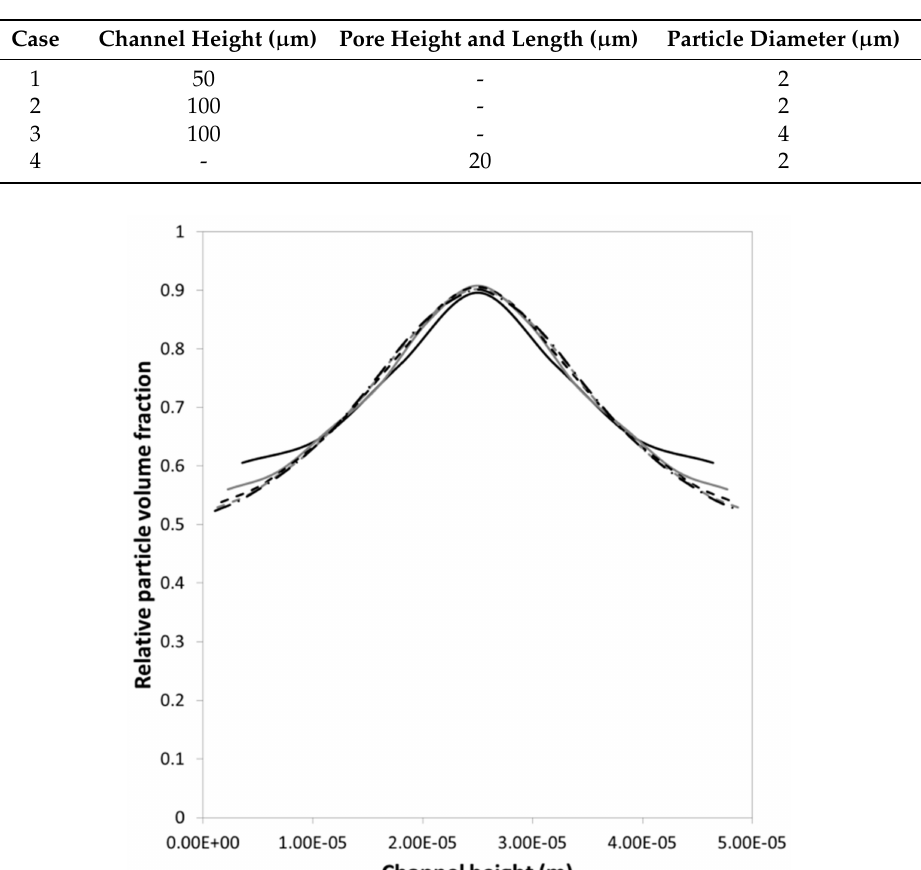
Figure A1. Grid refinement study for case 1. The relative particle volume fraction versus the channel height, measured 2.5 cm from the channel entrance. The grid cell number of the channel height is changed: 7 grid cells (black solid line); 11 grid cells (grey solid line); 15 grid cells (black dashed line); 19 grid cells (grey dashed line) and 23 grid cells (black dashed-dotted line) (Graph is reprinted from Separation and Purification Technology, 192, I. Drijer; T. van de Laar; H.M. Vollebregt and